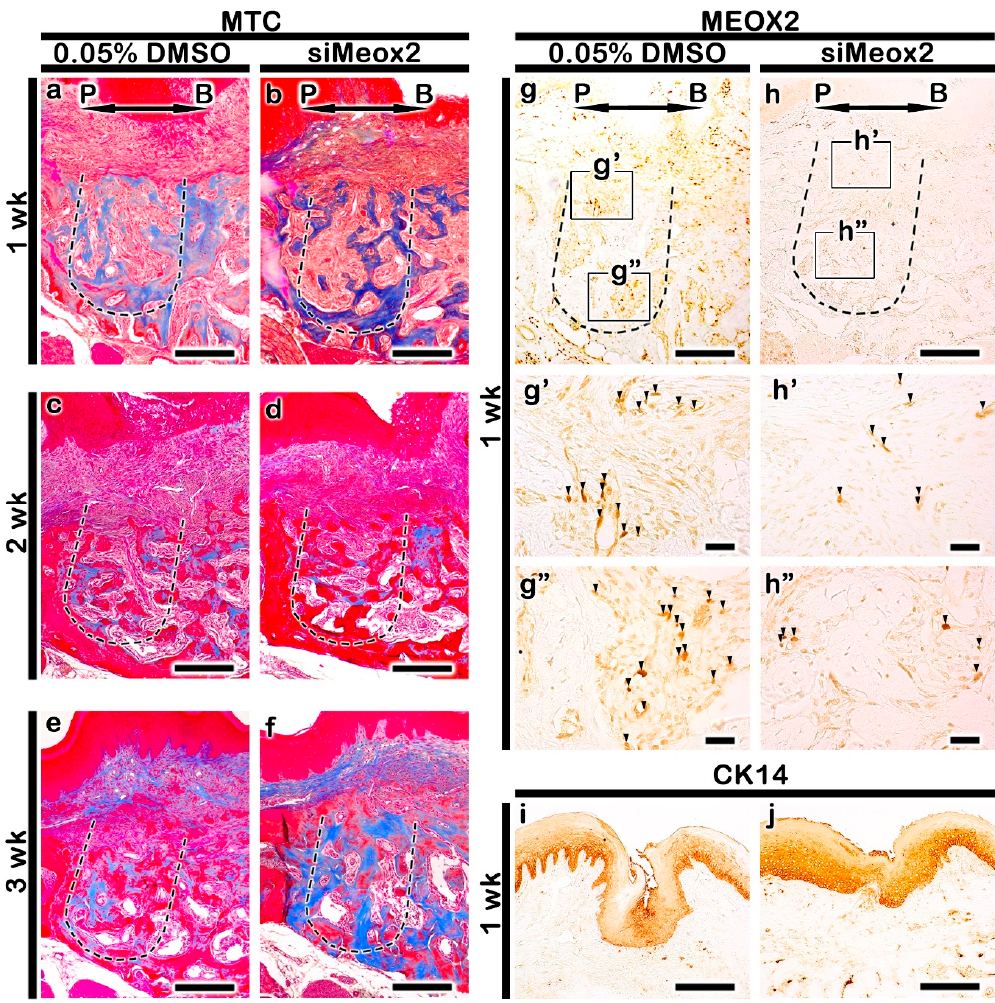
Figure 3. Expression pattern of Meox2 ( g , h ) in tooth root socket, MTC ( a – f ) and CK14 ( i , j ) staining showing the formation of collagen and keratinization. After 1, 2, and 3 weeks of the knocking down of Meox2 , the carrier control (DMSO)-treated specimens ( a , c , e ) have reduced volume of collagen (blue color) compared with that in the knocking down of Meox2 ( b , d , f ).The keratinization in carrier control treated specimens is reduced compared with that in si Meox2 ( i , j ). P, palatal and B, buccal. Dotted line demarcates the root region of the socket. The solid boxes depict higher magnification views ( g ′ – h ″ ). Scale bars 200 µm ( a – j ), 100 µm ( g ′ , g ″ , h ′ , h ″ ). Black arrowheads in g’h’-g”h” indicate Meox2 positive cells.